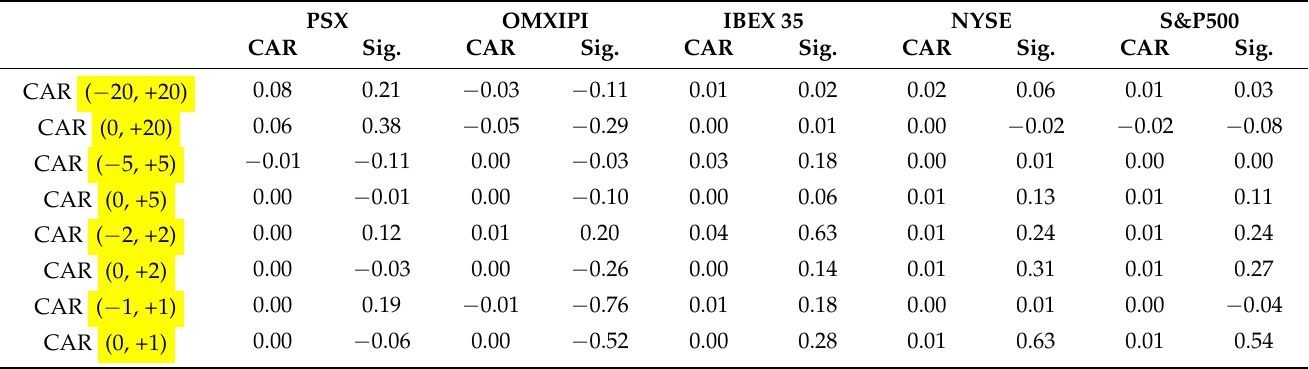
Table A39. Cumulative abnormal returns (Resignation of D. Jos é Manuel Soria, Spain’s Minister of Industry).